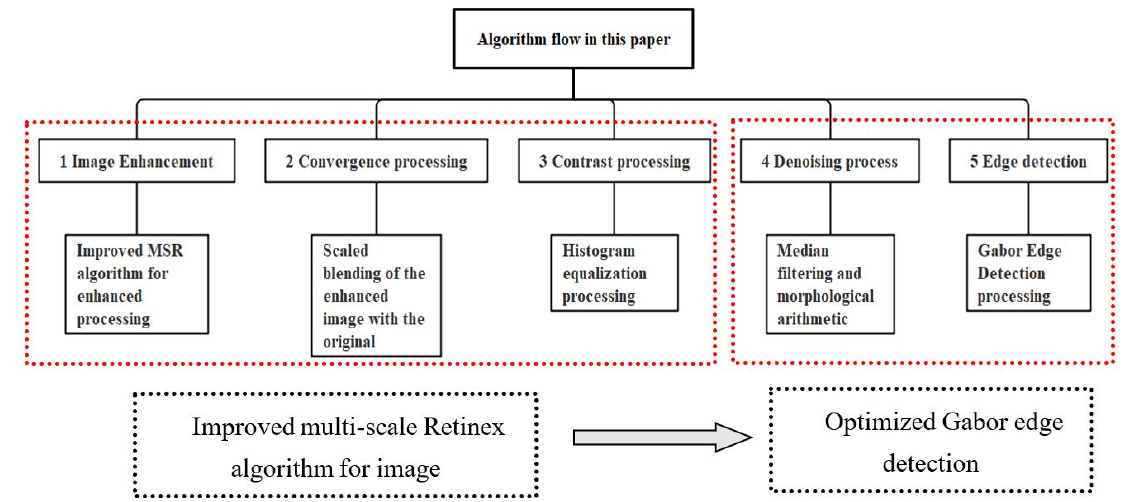
Figure 1. Flow chart of the algorithm in this paper.